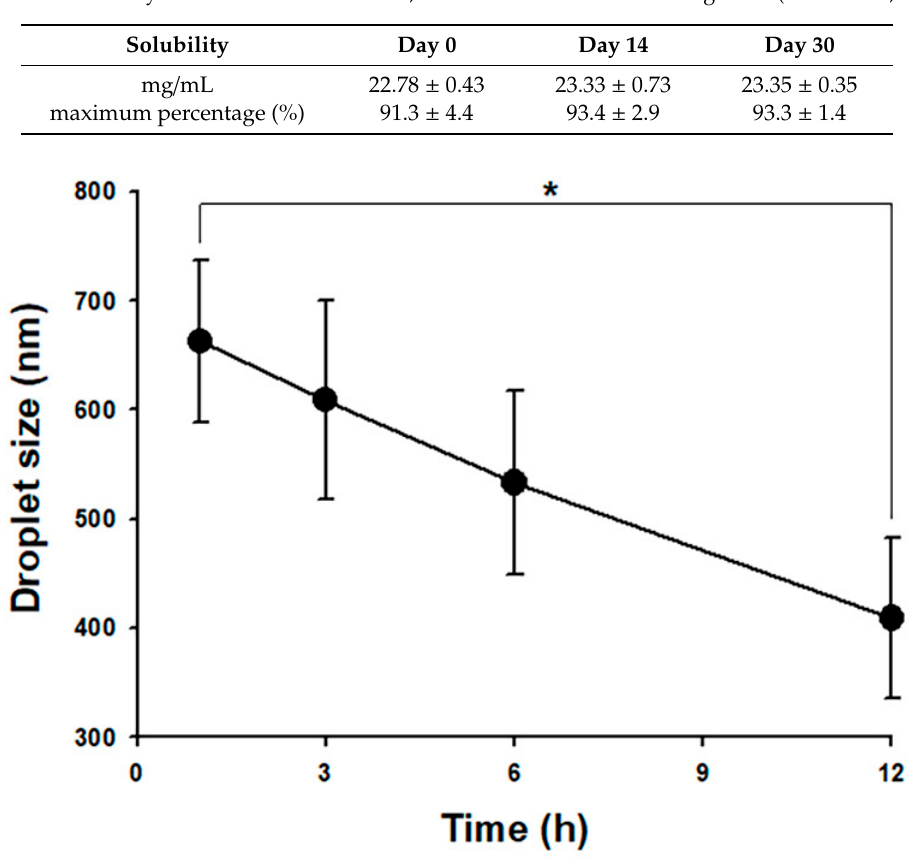
Table 1. The physicochemical properties of the two selected microemulsions. (Mean ± SD, n = 3).